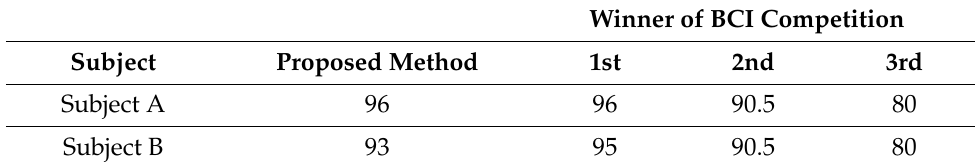
Table 4. Accuracy obtained by the different classifiers